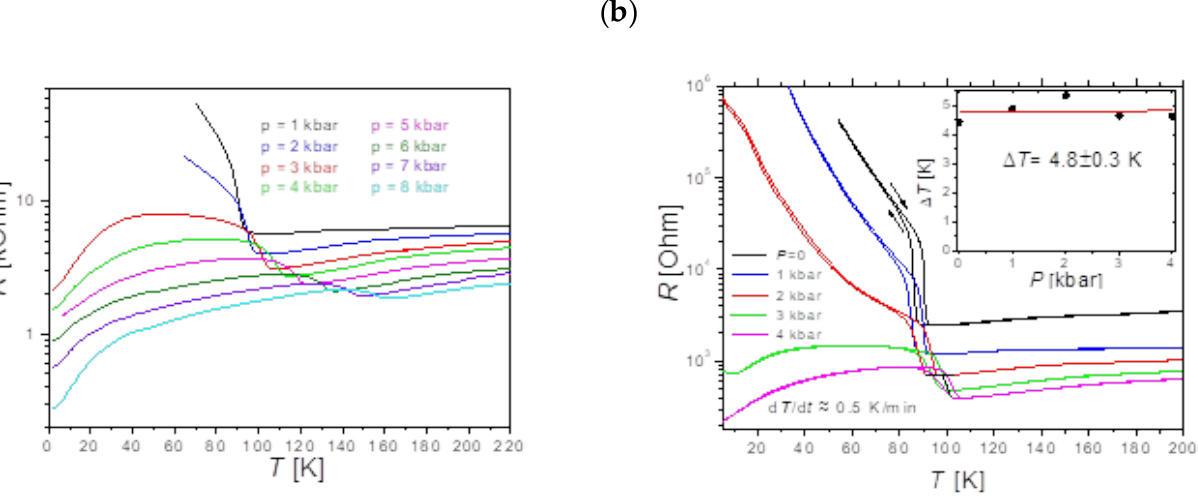
Figure 2. Temperature dependences of the interlayer resistance at various pressures recorded in the sample cooling mode for sample 1 ( a ) and showing the temperature hysteresis for sample 2 ( b ). The pressure dependence of the width of the hysteresis loop is shown in the inset.